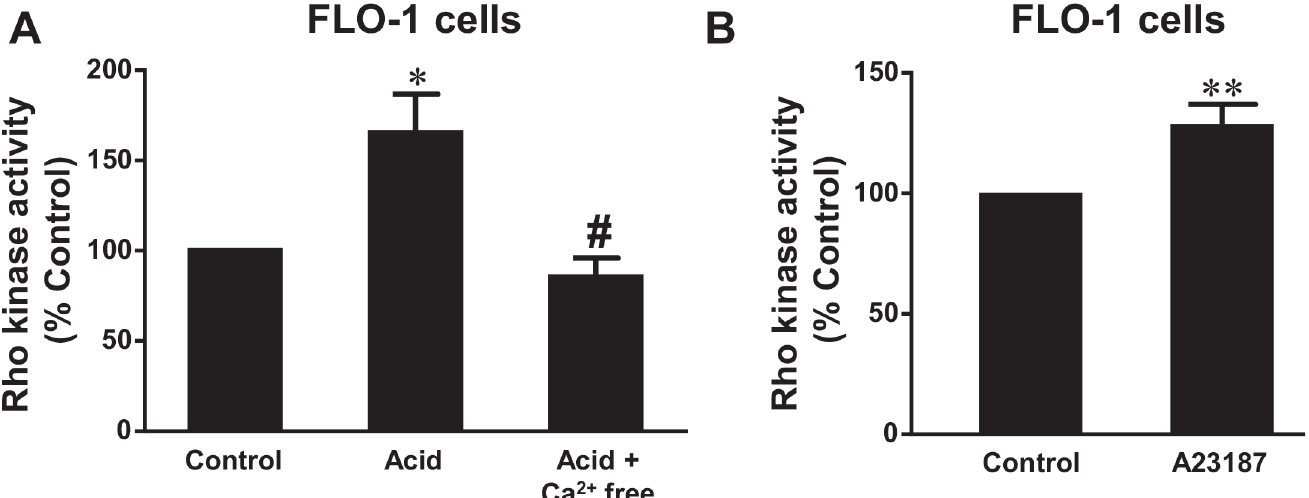
Fig 6. Role of calcium in Rho kinase activation. A. Acid treatment (pH 4.0, 1 hour) significantly increased Rho kinase activity, an increase which was blocked by the removal of calcium with calcium free medium plus 1 mM EGTA and 1 μ M thapsigargin, suggesting that acid-induced activation of Rho kinase may be dependent on intracellular calcium increase. B) A23187 significantly increased Rho kinase activity, suggesting that intracellular calcium increase may activate Rho kinase in FLO-1 EA cells. N = 3, ANOVA * P < 0.05, compared with control group; # P < 0.05, compared with acid group; t test ** P <